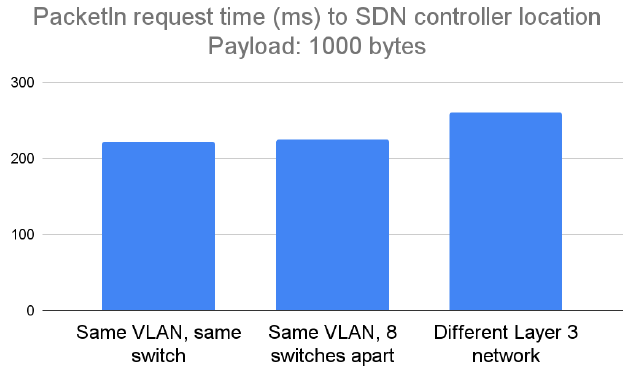
Figure 8. Experimental results of running the design for portability in case of a PacketIn packet having a payload of 1000 bytes, considered a medium payload. having a payload of 1000 bytes, considered a medium